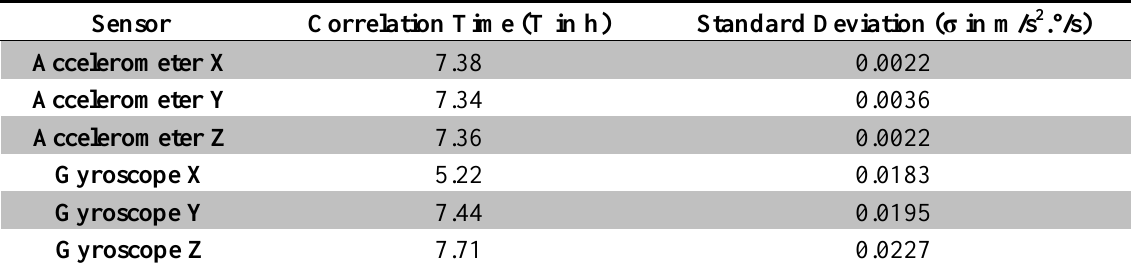
Table 3. Gauss Markov parameter for accelerometers and gyroscopes.